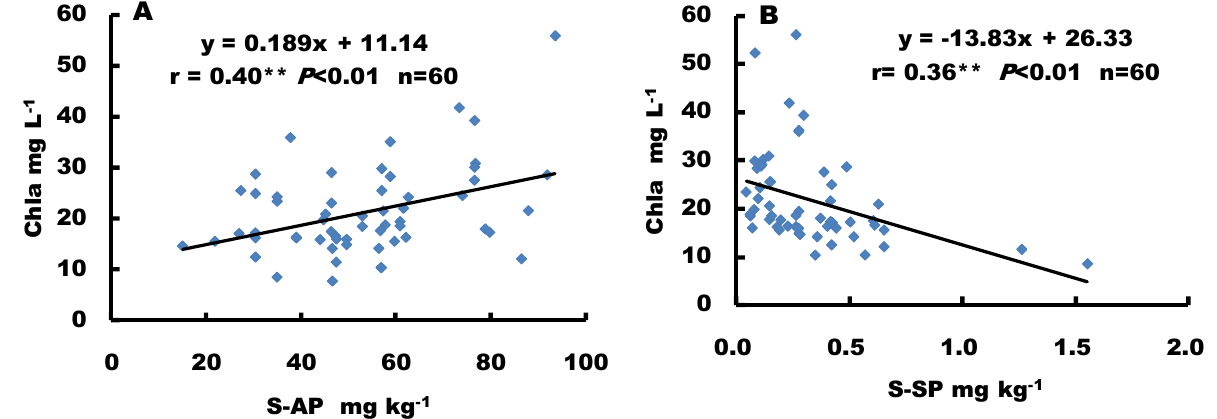
Figure 6. ( A , B ) Correlations between sediment available-P (S-AP), soluble-P (S-SP), and Chlorophyll-a (Chl- a ). ** indicates a very significant correlation.